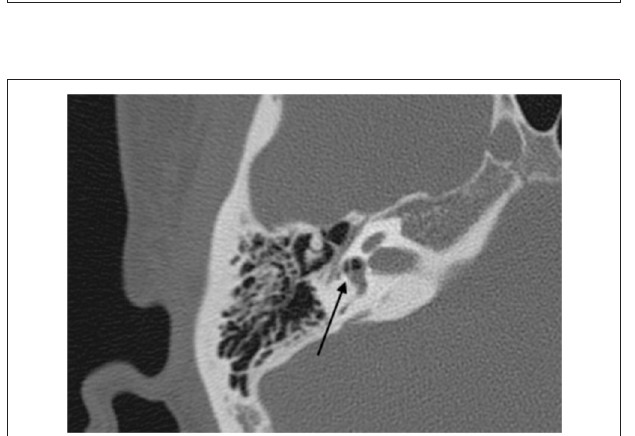
FIGURE 1 | Preoperative audiogram. A severe mixed sensory and conductive hearing loss is observed on the right ear, and an air–bone gap is present at low frequencies.